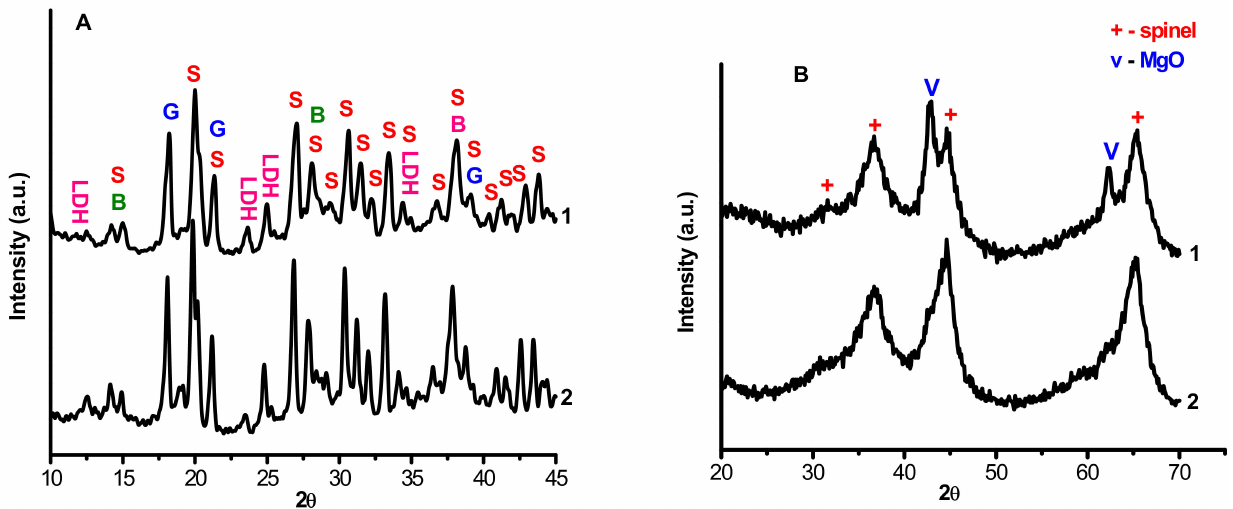
Figure 1. Powder diffraction patterns of the samples before ( A ) and after ( B ) calcination: 1—MgAl(1)-110 and MgAl(1)-550; 2—MgAl(2)-110 and MgAl(2)-550; S—Mg(NO 3 ) 2 · 6H 2 O; G—gibbsite; B—boehmite; LDH—double